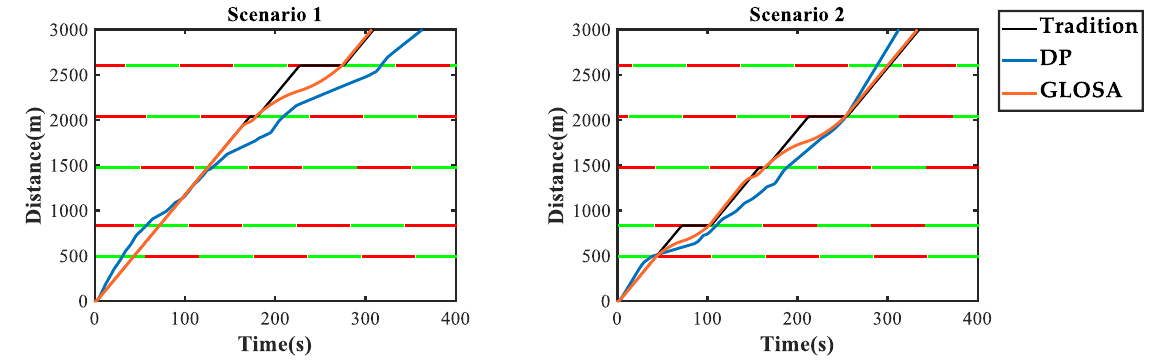
Figure 8. Time – space domain trajectories of different scenarios.